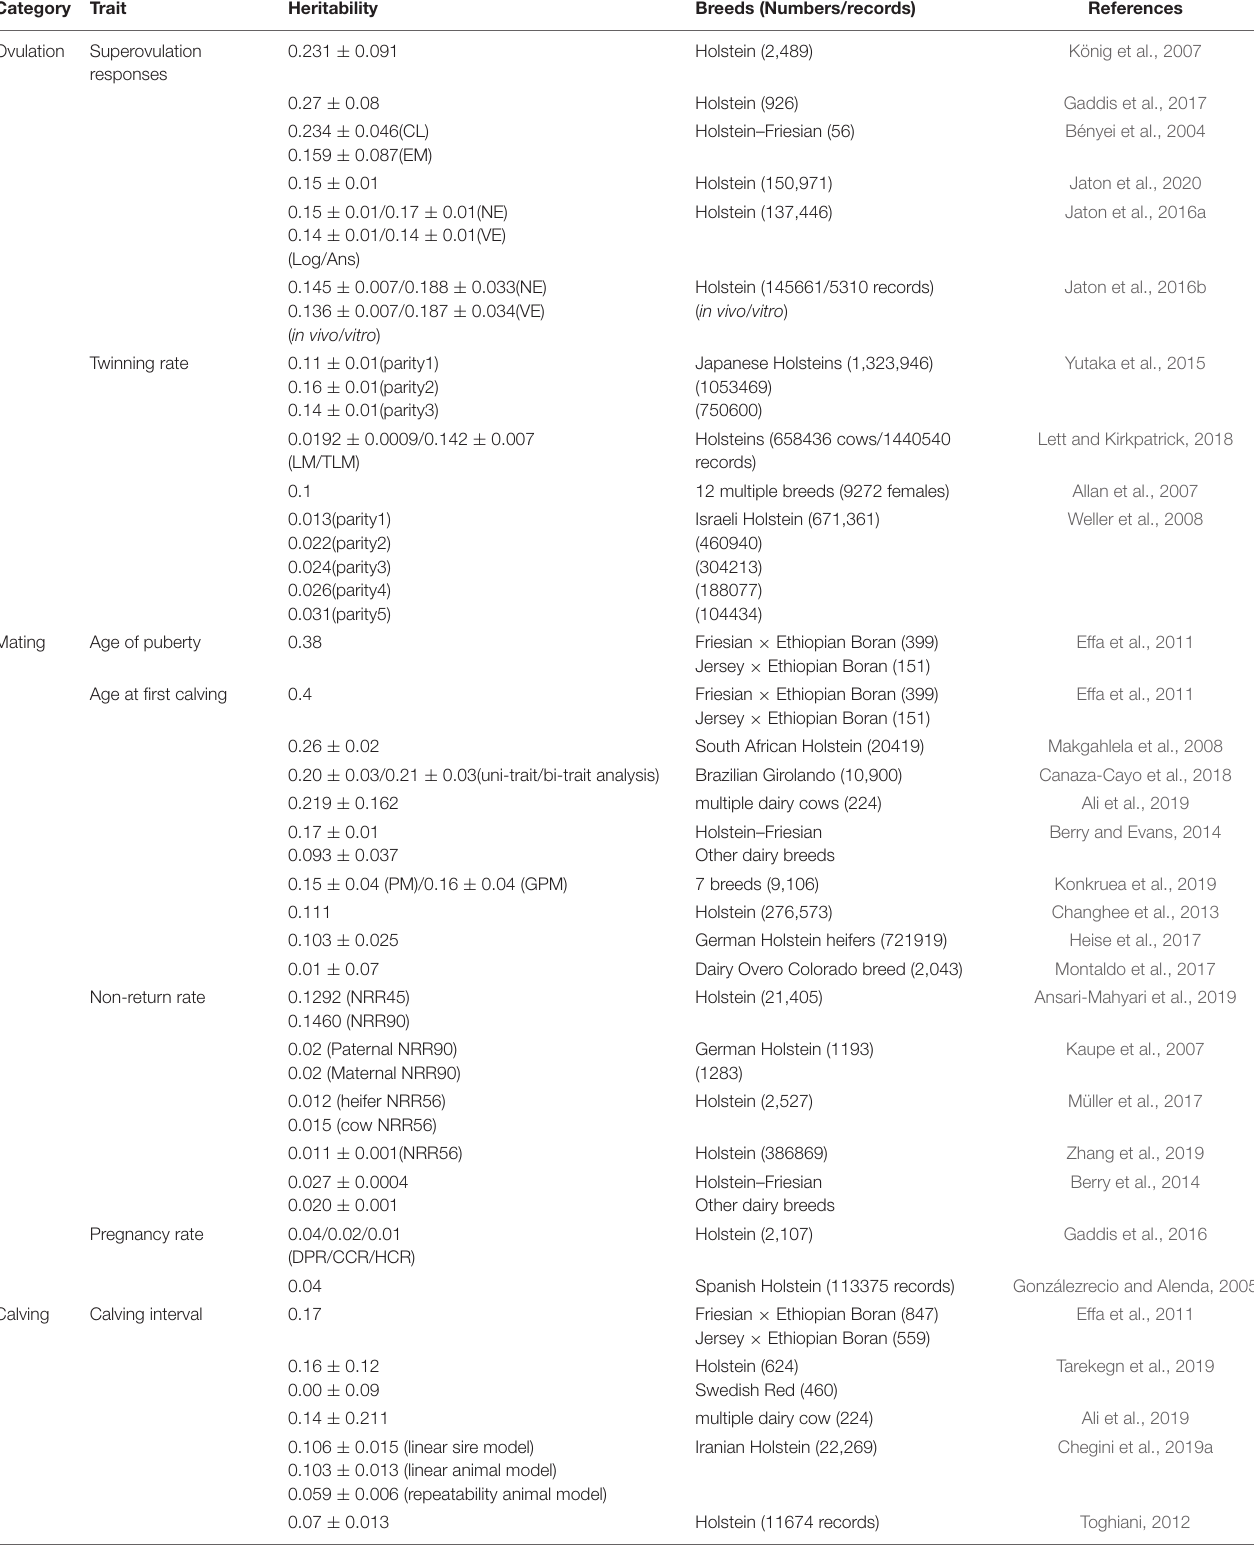
TABLE 2 | Heritability estimates of reproduction traits in dairy